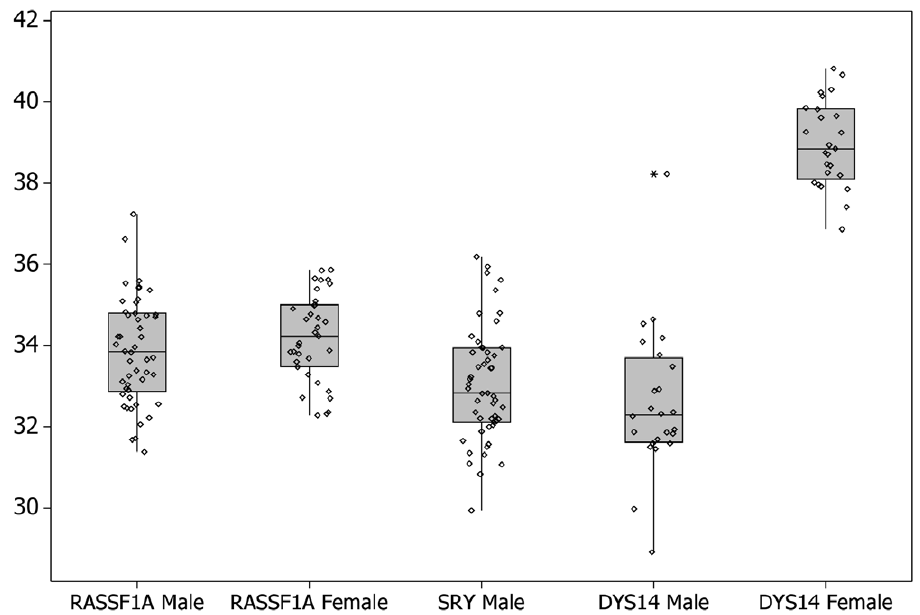
Figure 2. Box plots showing the Ct values for RASSF1A , SRY and DYS14 real time PCR assays for male and female pregnancies. The mean Ct values were 33.9 ( RASSF1A , male fetuses), 34.2 ( RASSF1A , female fetuses), 33.0 ( SRY , male fetuses), 0 ( SRY , female fetuses), 32.5 ( DYS14 , male fetuses) and 39.2 ( DYS14 , female fetuses).